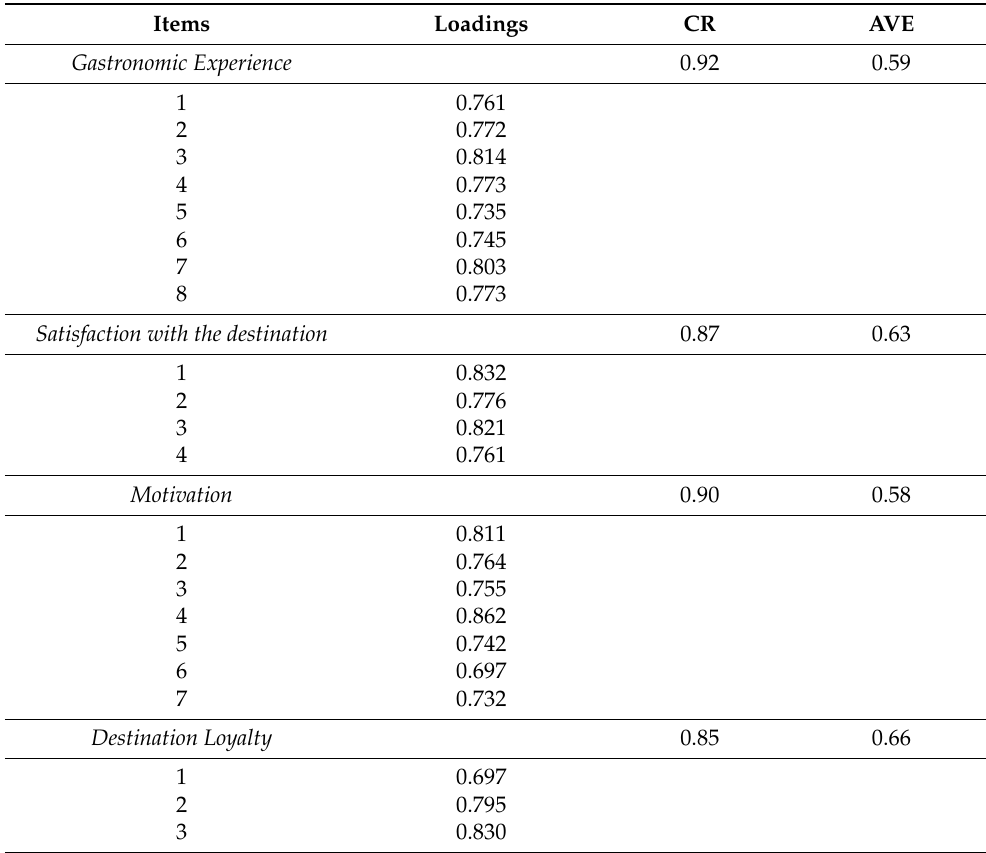
Table 3. Factors Loading.